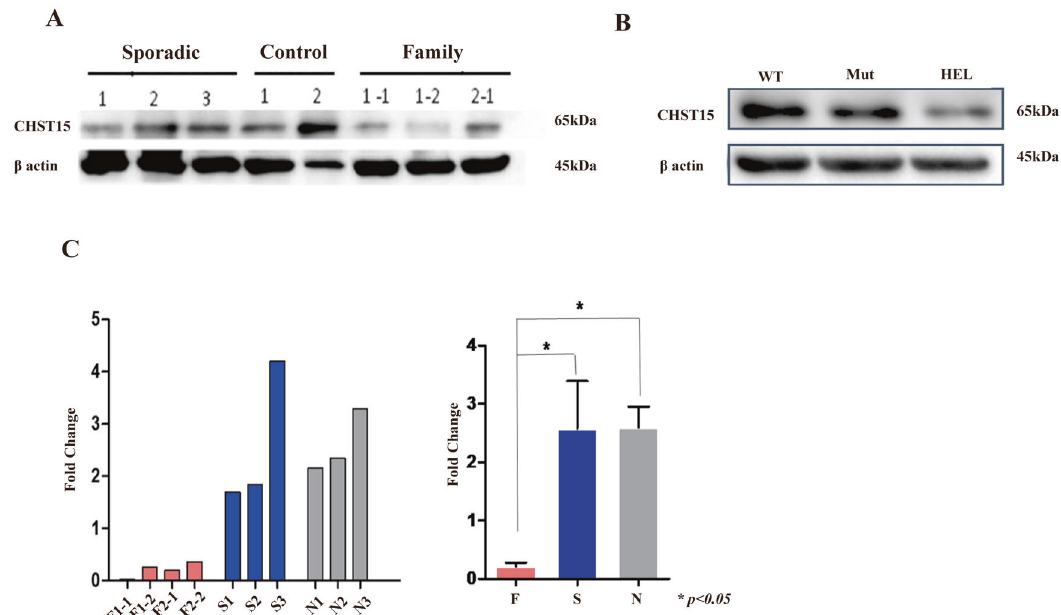
Fig. 4 CHST15 protein and mRNA expression in familial MPN patients and HEL cells with CHST15 mutant (Western blot results). A from left to right, CHST15 blotting bands represent sporadic MPN patients; healthy controls and familial MPN, respectively. B CHST15 protein expression on HEL cells with wild-type CHST15 (WT) and mutant CHST15 gene(Mut) and non - transfected HEL cells (HEL). C Quantitative RT-PCR analysis of CHST15 mRNA. Left panel: from left to right, F1-1, F1-2, F2-1, F2-2 indicate familial PMF; S1, S2, S3 indicate sporadic PMF; N1, N2, N3 indicate normal individuals. Results are means of three independent experiments. Right panel: when the mRNA expression levels were compared by pairwise comparison, the results showed that there was signi fi cantly depressed expression on CHST15 mRNA in familial MPN ( p <